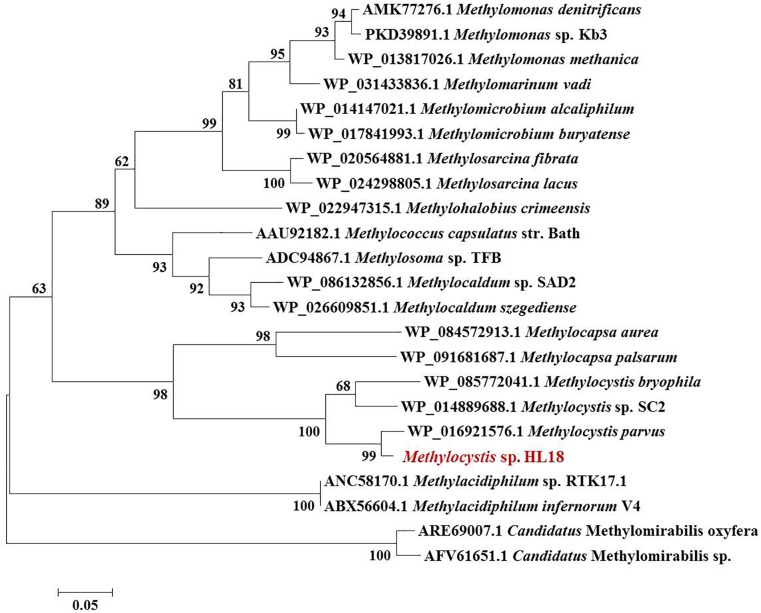
Phylogenetic tree of PmoA based on amino acid sequences. The microorganism in red font was the one recovered in this study. PmoA of Methylomirabilis genus belonging to NC10 phylum were used as the outgroup members of this tree. Numbers indicated the bootstrap support (1000 replicates).